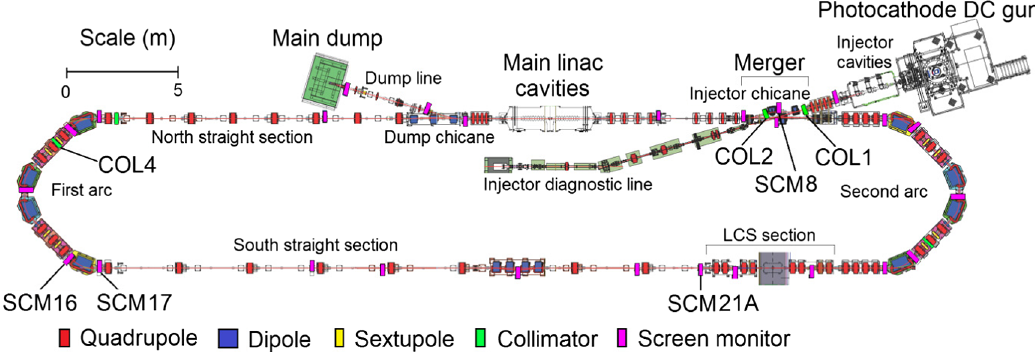
FIG. 1. Layout of cERL and locations of measurement equipment. The collimators COL1 and COL2 are located at the end of the injector before the first bending magnet, and between the second and the third bending magnets of the merger section, respectively. COL4 is located in the first arc section. The positions of screen monitors SCM8, 16, 17, and 21A are chosen to observe beam halo profiles in the merger section, at the first arc, at the exit of the first arc, and at the end of the south straight section,